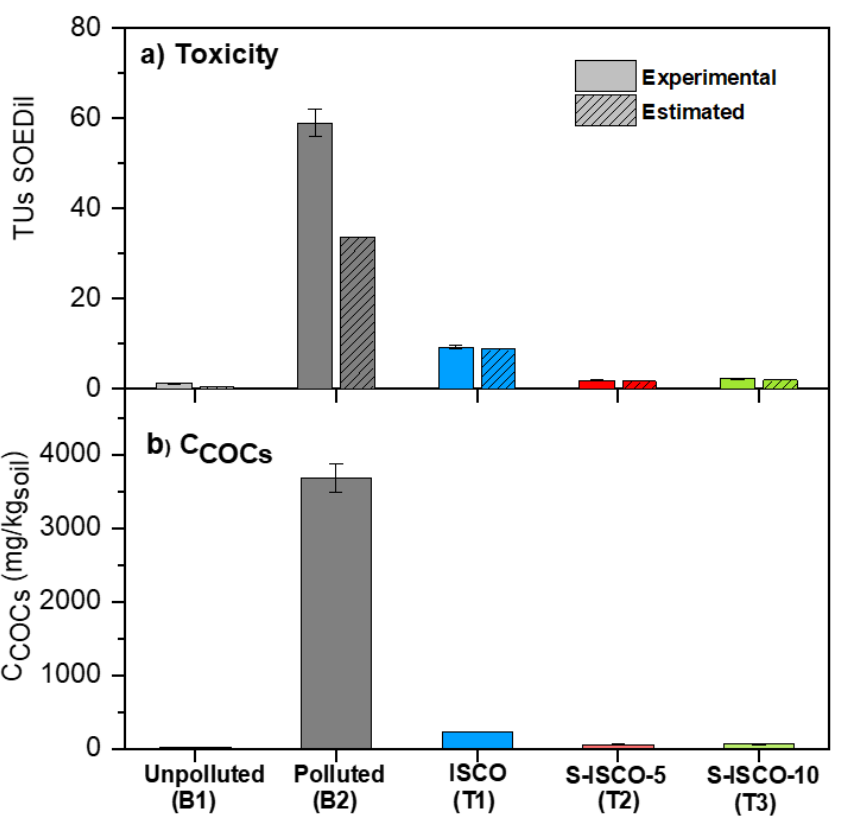
Figure 3. Soil organic extract toxicity (TUs SOEDil, Microtox ® aOSSST) ( a ) and COCs concentration (mg/kg soil ) ( b ) of the unpolluted, polluted, and treated